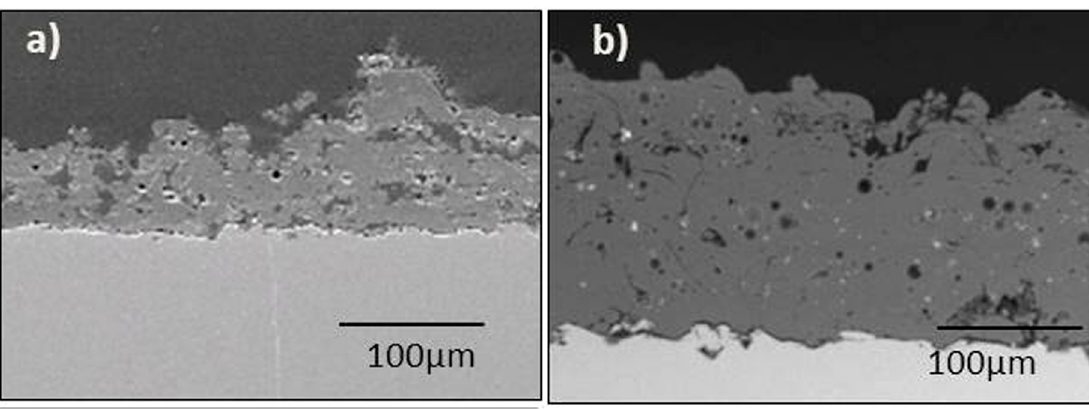
Figure 2. SEM micrographs of the cross section of: ( a ) wollastonite and ( b ) wollastonite-diopside glass